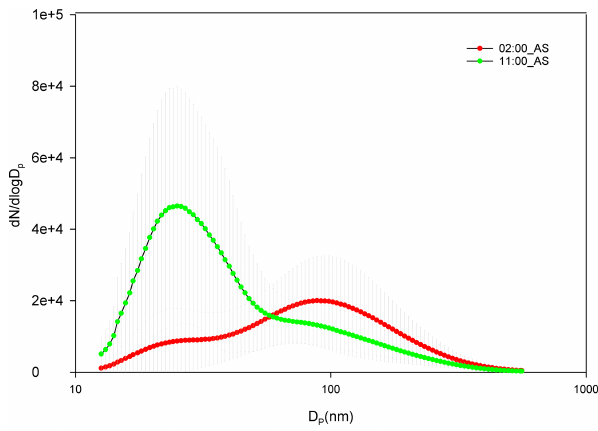
Figure 7. Comparison of two size distribution profiles at different times of day for AS branch at 02:00 and